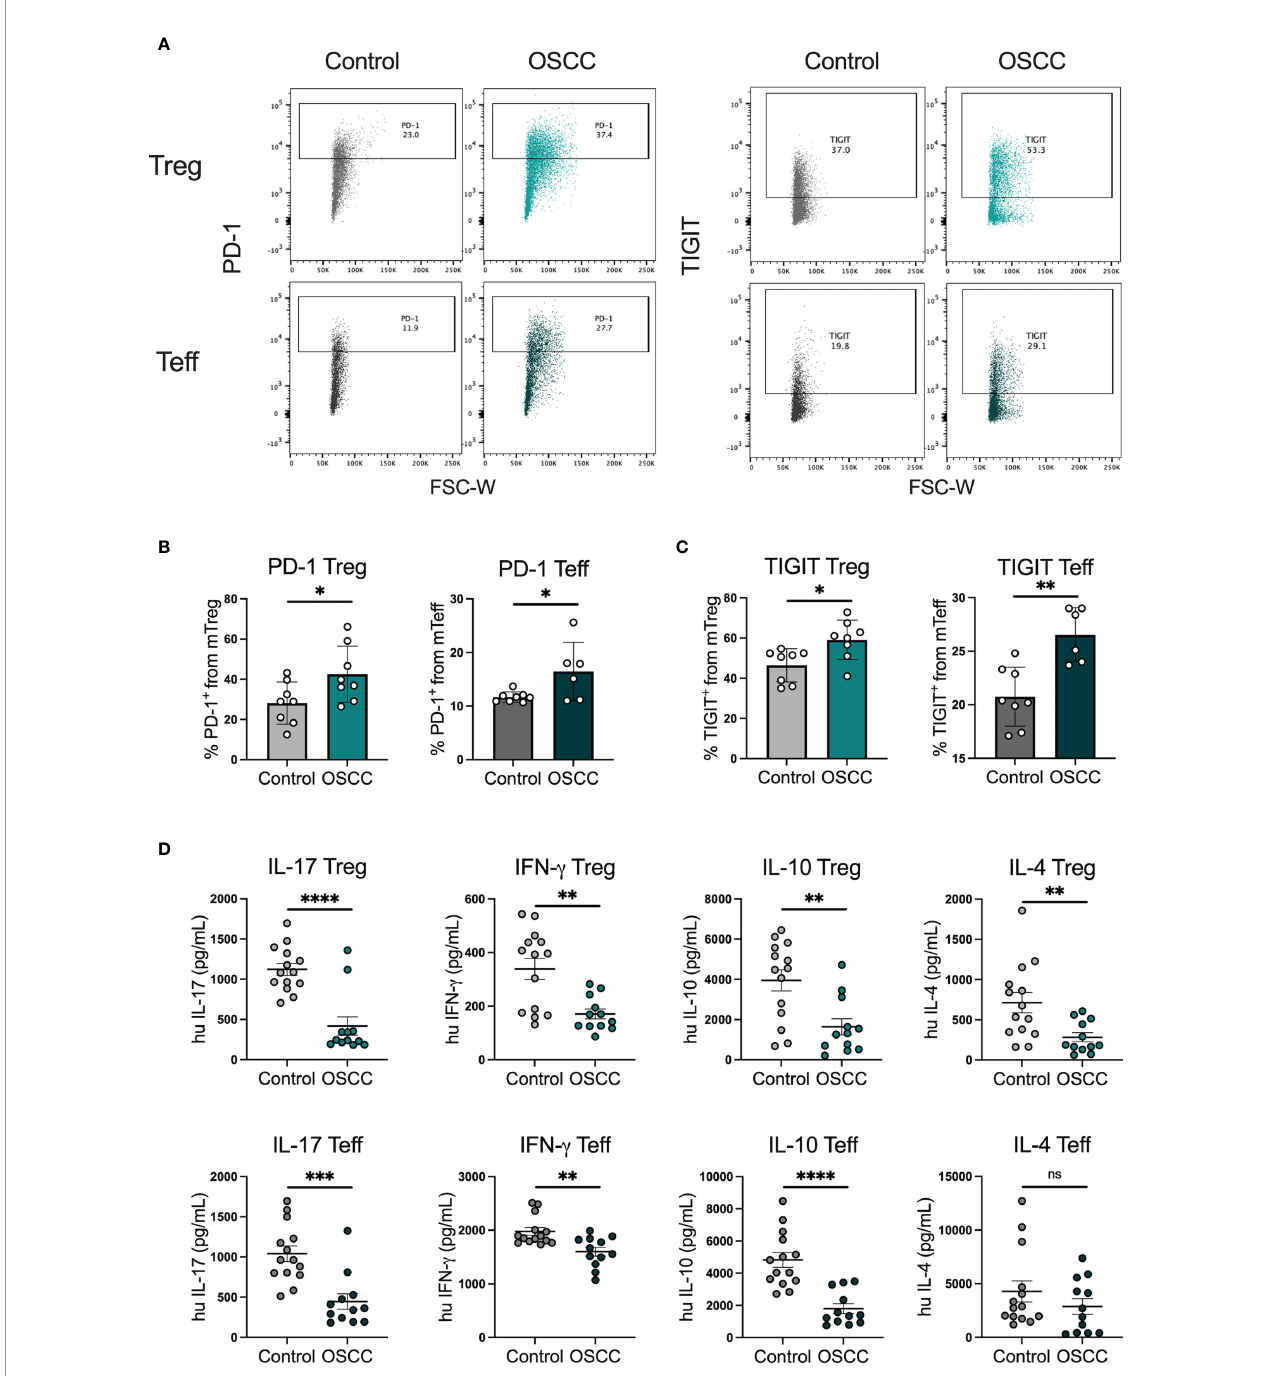
FIGURE 3 | OSCC secretome promote PD-1 and TIGIT expression and inhibit cytokine production in comparison with control secretome. (A) Representative dot plots of PD-1 and TIGIT expression in Tregs and Teff after co-culture with control or OSCC secretome. Brie fl y, sorted memory Tregs and Teff obtained from peripheral blood from 4 healthy donors were pre-activated with anti-CD3/CD28 beads (1:5) in the presence of IL-2 (1000U). After activation, 2x10 5 Tregs and Teff were co-cultured with secretomes from OSCC or control samples for 48h and cells were stained with PD-1 and TIGIT, whereas the supernatants were used to measure cytokines using cytokine bead array. Expression of both suppressive molecules was measured by fl ow cytometry. (B) Comparison of PD-1 expression between memory Tregs and Teff co-cultured with OSCC or control secretome. (C) Comparison of TIGIT expression between memory Tregs and Teff co-cultured with OSCC or control secretome. (D) Comparison of secreted Th cytokines from Tregs and Teff co-cultured with OSCC or control secretome. Data are presented as mean ± SEM using bars with scatter dot plots for phenotype and scatter dot plots for cytokine secretion (Unpaired t test). For all statistical tests, ∗∗∗∗ p < 0.0001, ∗∗∗ p < 0.001, ∗∗ p < 0.01 and ∗ p < 0.05 were considered signi fi cant. ns, not signi fi